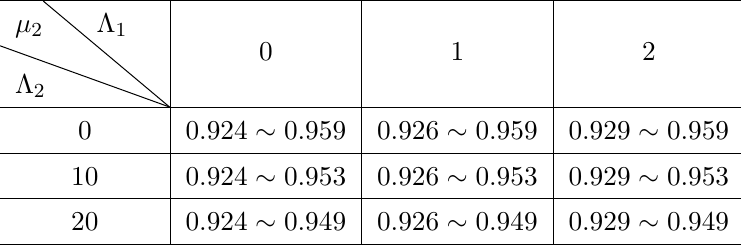
Table 5 . The domain of existence of the mass µ 2 of the scalar field φ 2 for different values of Λ 1 and Λ 2 . All solutions have µ 1 = 1 , m 1 = 1 and m 2 = 1